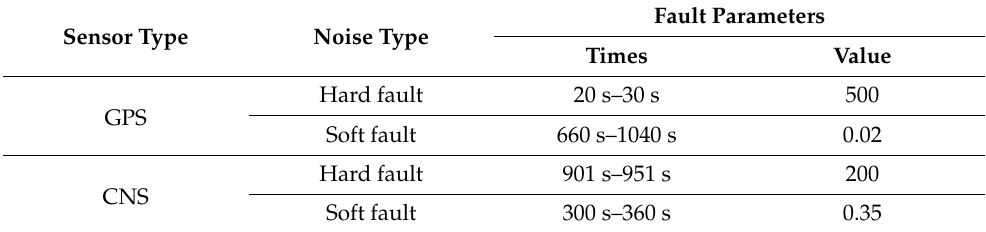
Table 3. Fault parameter setting.